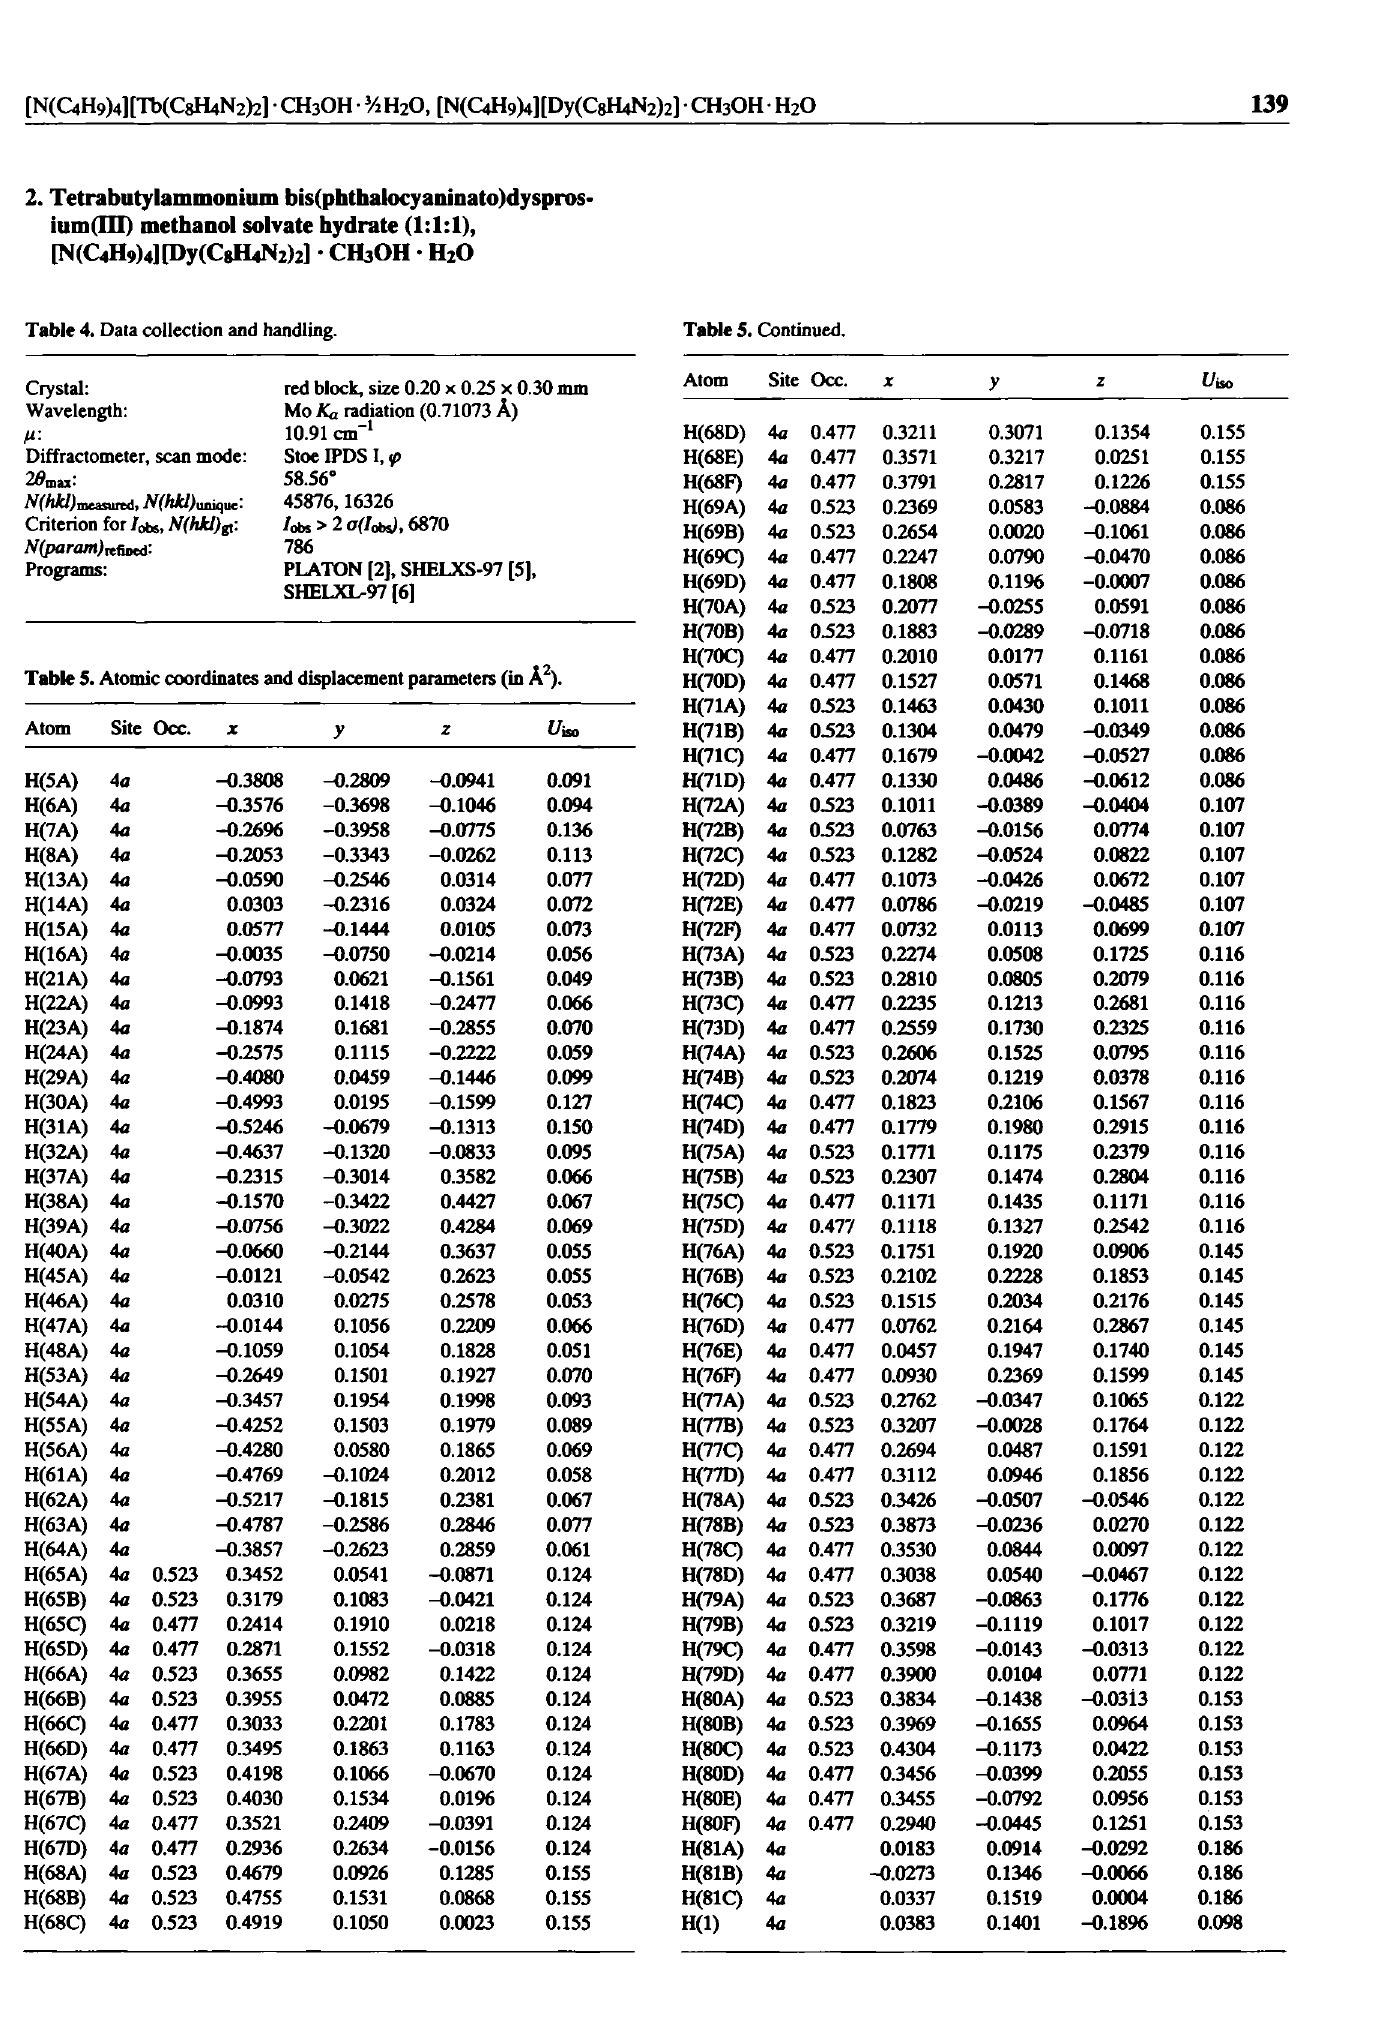
Table 5. Atomic coordinates and displacement parameters (in Ä 2